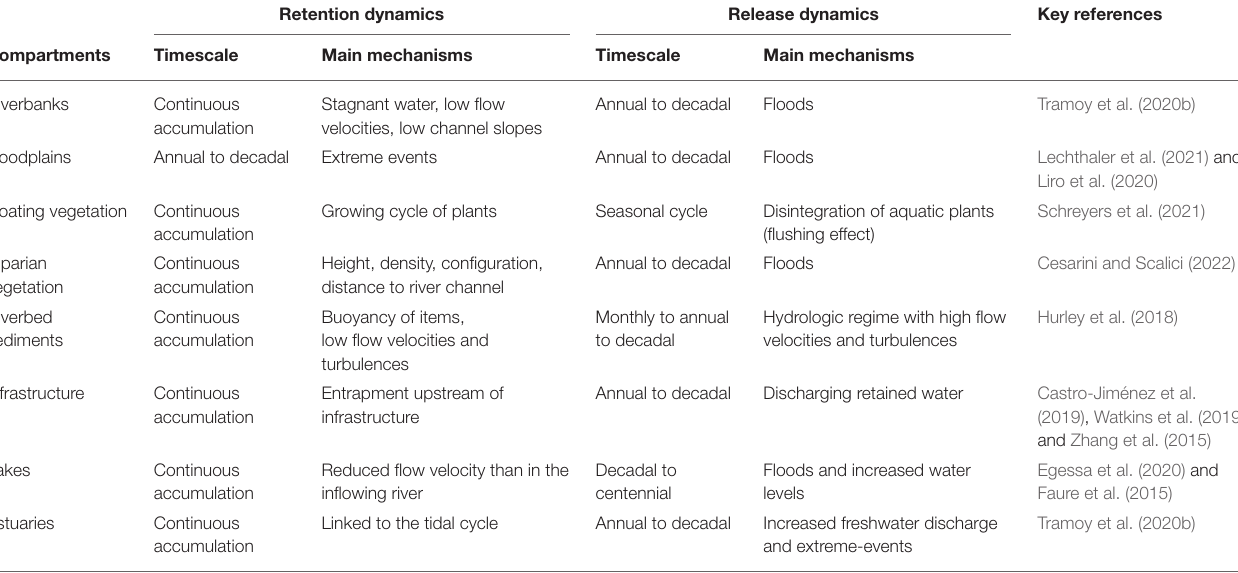
TABLE 1 | Overview of the retention and release dynamics, and their timescales, discussed in this